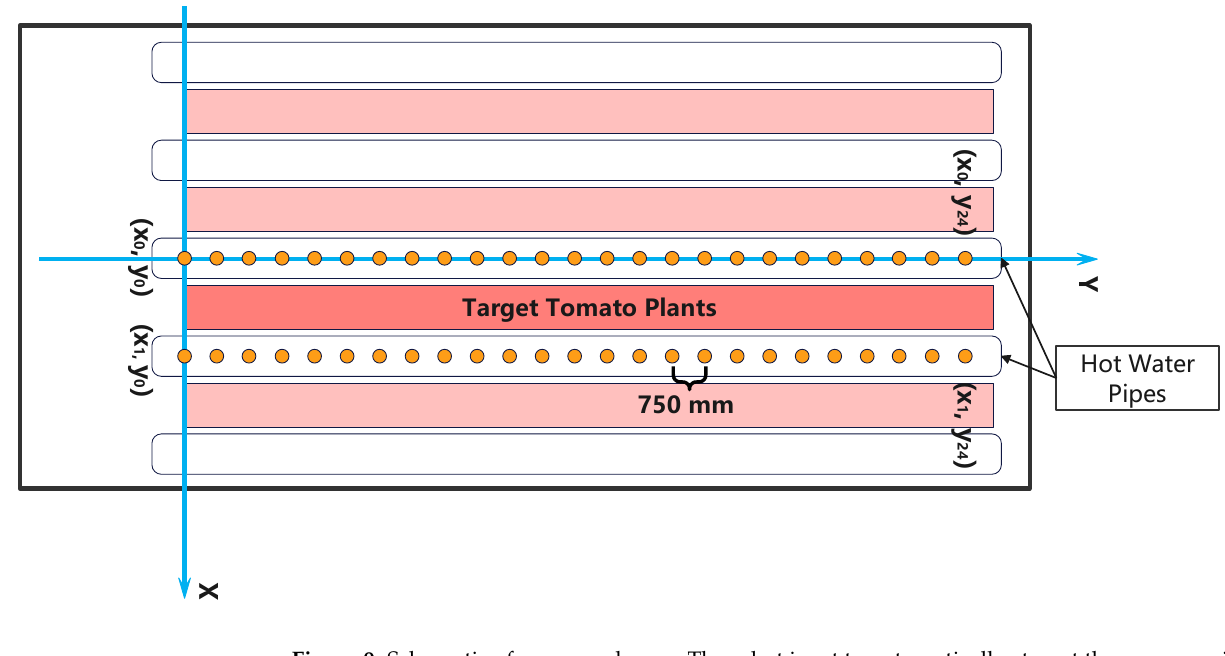
Figure 9. Schematic of our greenhouse. The robot is set to automatically stop at the orange point to collect image data of